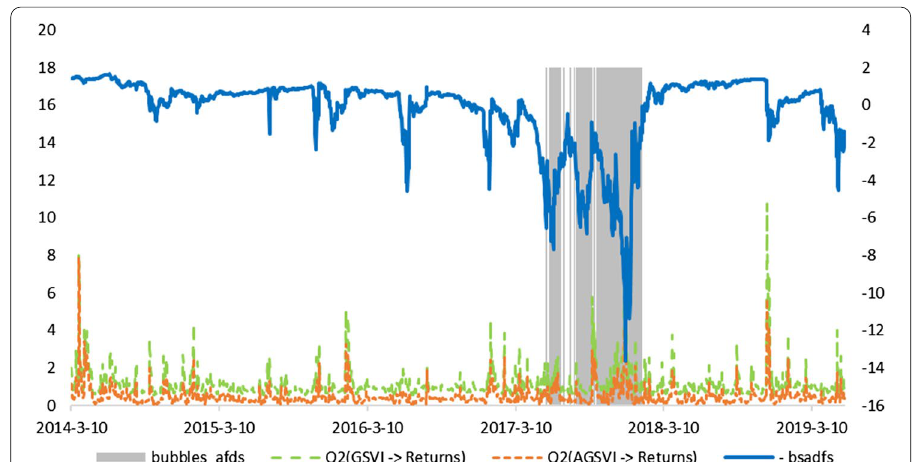
Fig. 9 Time-varying Granger Causality test results of GSVI (AGSVI) to Bitcoin returns and detected bubbles. Note: Left axis: blue solid line is Q2(GSVI- > Returns), TV-GC test statistics from GSVI to Bitcoin returns; green dotted line is Q2(AGSVI- > Returns), TV-GC test statistic from AGSVI to Bitcoin returns; right axis: blue solid line is -bsadf, the additive inverse of test statistics of bubble occurrence; Gray shade is the detected bubbles